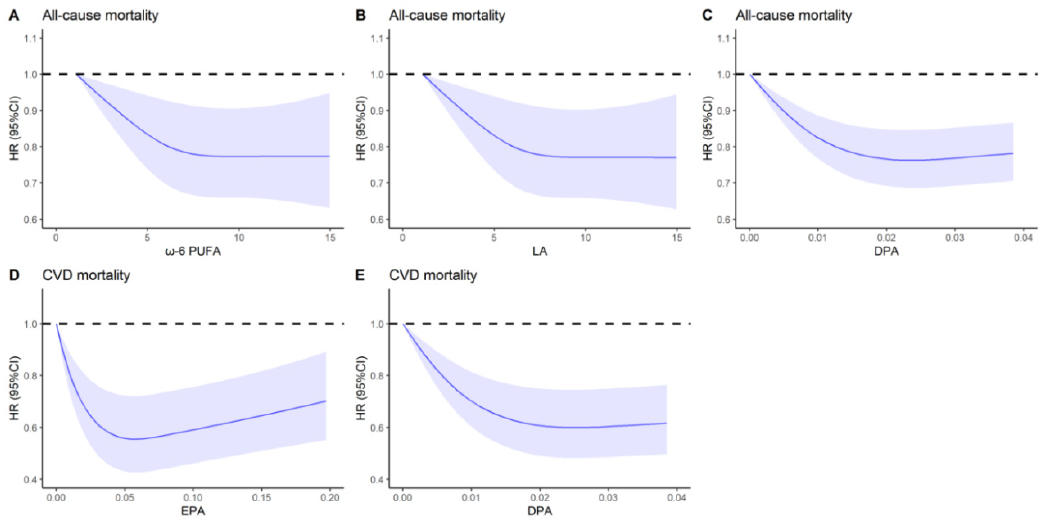
Figure 3. Dose–response relationships of effective dietary acids with all-cause and CVD mortality among patients with CMD in NHANES III and NHANES 1999–2014 a . a : Dose–response relation- ships between effective dietary acids with all-cause and CVD mortality among patients with CMD, ( A ) ω -6 PUFA in all-cause mortality ( p nonlinear = 0.0454), ( B ) LA in all-cause mortality ( p nonlinear = 0.0447), ( C ) DPA in all-cause mortality ( p nonlinear < 0.0001), ( D ) EPA in CVD mortality ( p nonlinear < 0.0001), ( E ) DPA in CVD mortality ( p nonlinear < 0.0001) in NHANES III and NHANES 1999–2014 were estimated by multivariable adjusted Cox regression models based on restricted cubic splines. Solid splines represented estimated hazard ratios, and cloud areas represented the corresponding 95% CI. The multivariable-adjusted model was adjusted for gender, age, race, educational levels, PIR, BMI, smoking status, alcohol drinking status, physical activity status, self-reported health status, baseline history of hypertension, hyperlipidemia and cancer, total energy intake, energy intake derived from carbohydrate, protein intake (in tertiles), cholesterol levels (in tertiles), and energy intake derived from remaining fatty acids (SFA, MUFA, and PUFA) where appropriate. Abbreviation and acronyms: CMD, cardiometabolic disease; CVD, cardiovascular disease; ω -6 PUFA, ω -6 polyunsaturated fatty acids; LA, linoleic acid; EPA, eicosapentaenoic acid; DPA, docosapentaenoic